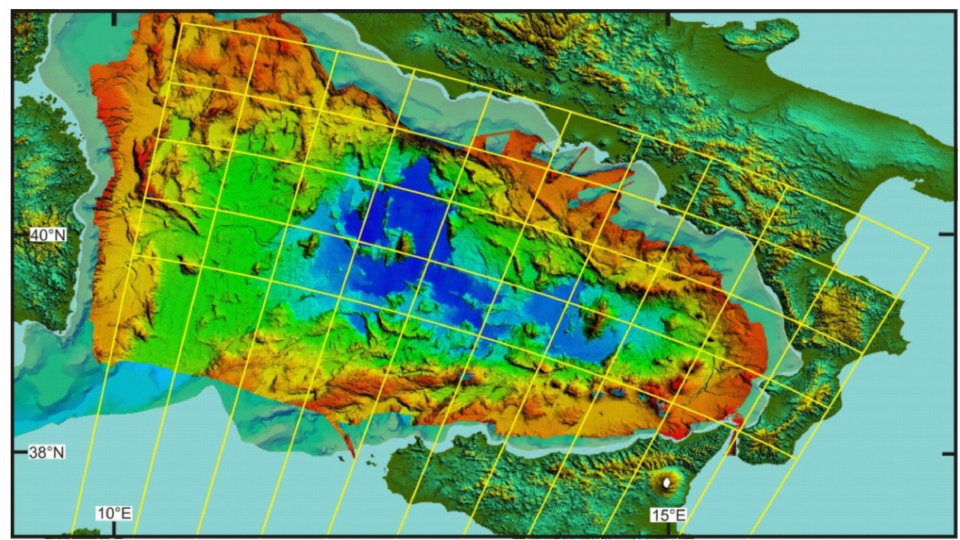
Figure 17. Morpho-structural lineaments of the southern Tyrrhenian and Euler pole grid of relative motion with respect to Sardinia-Corsica ( red dot ). The Euler pole grid shows the goodness of fit between kinematic model and geological structures. The Euler pole has coordinates: 21.85 ◦ 6.28 ◦